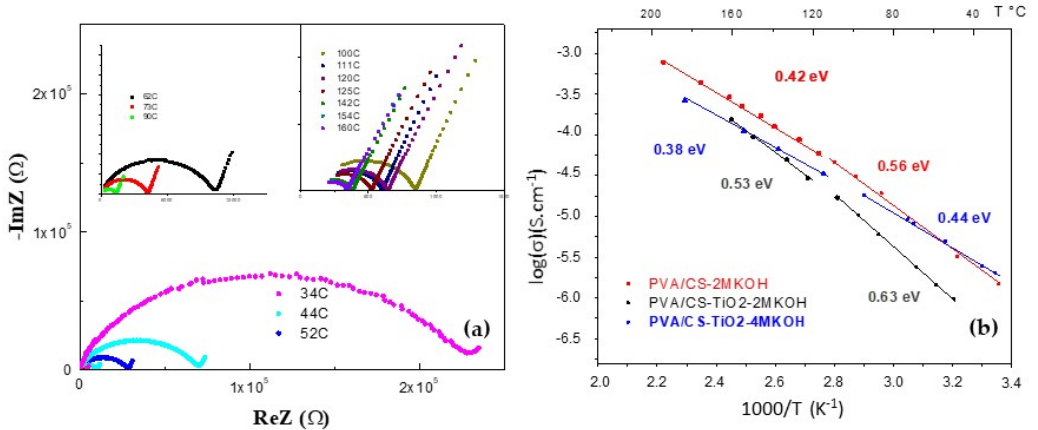
Figure 8. ( a ) Nyquist diagrams, −Z′′ vs. Z′, of the compound PVA/CS (1000 ppm TiO 2 ). ( b ) Arrhenius model, compound doped with KOH.